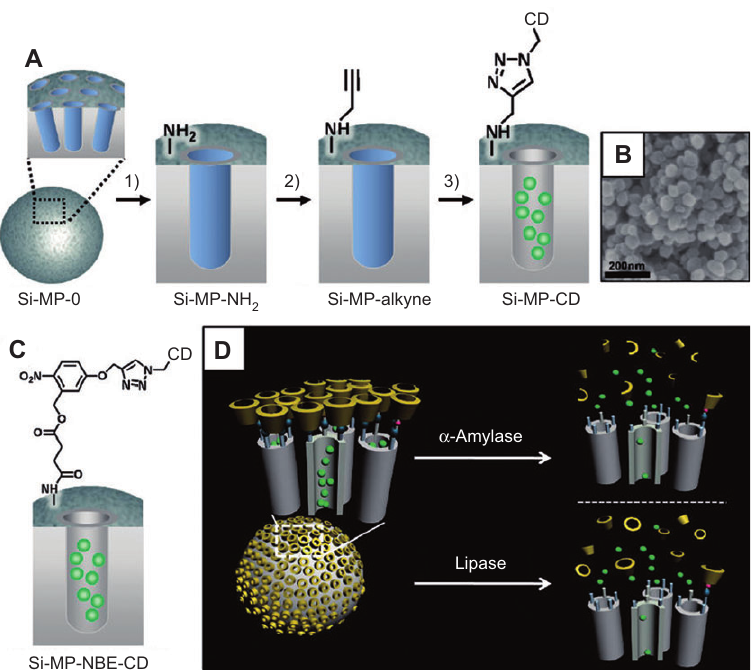
Figure 7 (A) Synthetic route to Si-MP-CD: (1) 3-aminopropyltriethoxysilane; (2) succinic anhydride and triethylamine; (3) removal of , sodium ascorbate, and mono-6-azido- β -CD. (B) FE-SEM image of Si-MP-CD. (C) The structure of surface functional CTAB, calcein, CuSO 4 motifs on Si-MP-NBE-CD. (D) Schematic illustration for enzyme-triggered release of guest molecules from the pore of CD-covered nanocon- tainers [45] . Reprinted with permission from Ref. [45] . Copyright (2009) American Chemical Society.